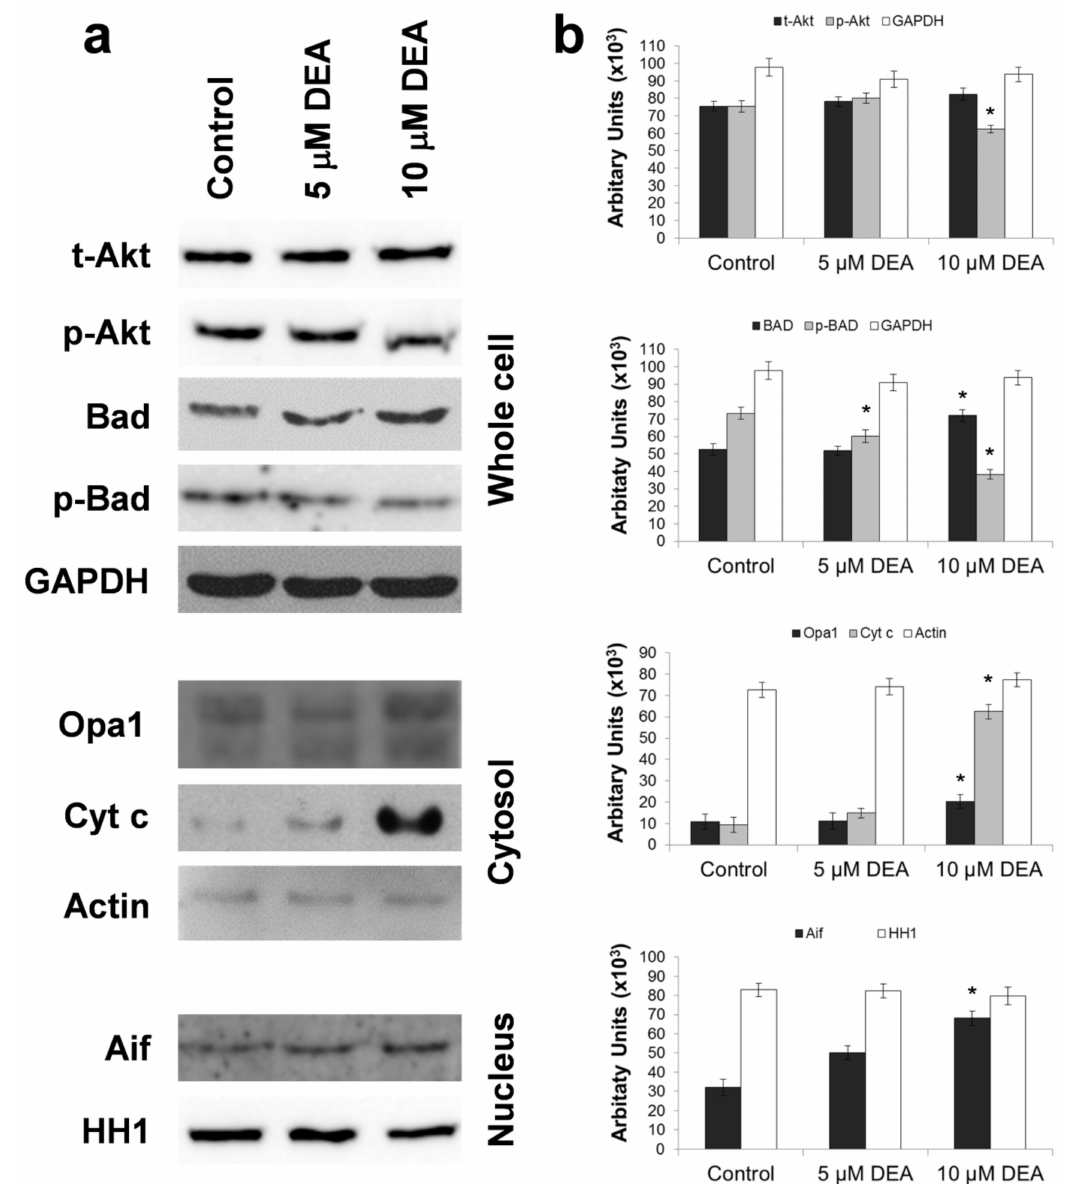
Figure 6. E ff ect of DEA on the OMM permeabilization in B16F10 melanoma cells. Cells were treated with 5 or 10 µ M of DEA for 6 h, harvested, and homogenized (Whole cell). Alternatively, nuclear and cytosolic fractions were prepared from the harvested cells. Steady-state levels and phosphorylation states of Akt and Bad were assessed in whole-cell homogenate. The steady-state levels of Cyt c and Opa1 were determined in the cytosolic, whereas that of Aif was measured in the nuclear fraction by immunoblotting. In the whole-cell homogenate, the cytosolic fraction and the nuclear fraction, we used glyceraldehyde-3-phosphate dehydrogenase (GAPDH), actin and histone H1 (HH1), respectively, as loading controls. The proteins were visualized by enhanced chemiluminescence. ( a ) Representative blots. ( b ) Quantitative assessment of proteins in the subcellular fractions. Results are expressed as pixel density or chemiluminescence intensity of the bands, both expressed in arbitrary units (means ± SEM of three independent experiments). * indicates a significant di ff erence relative to the control ( p <